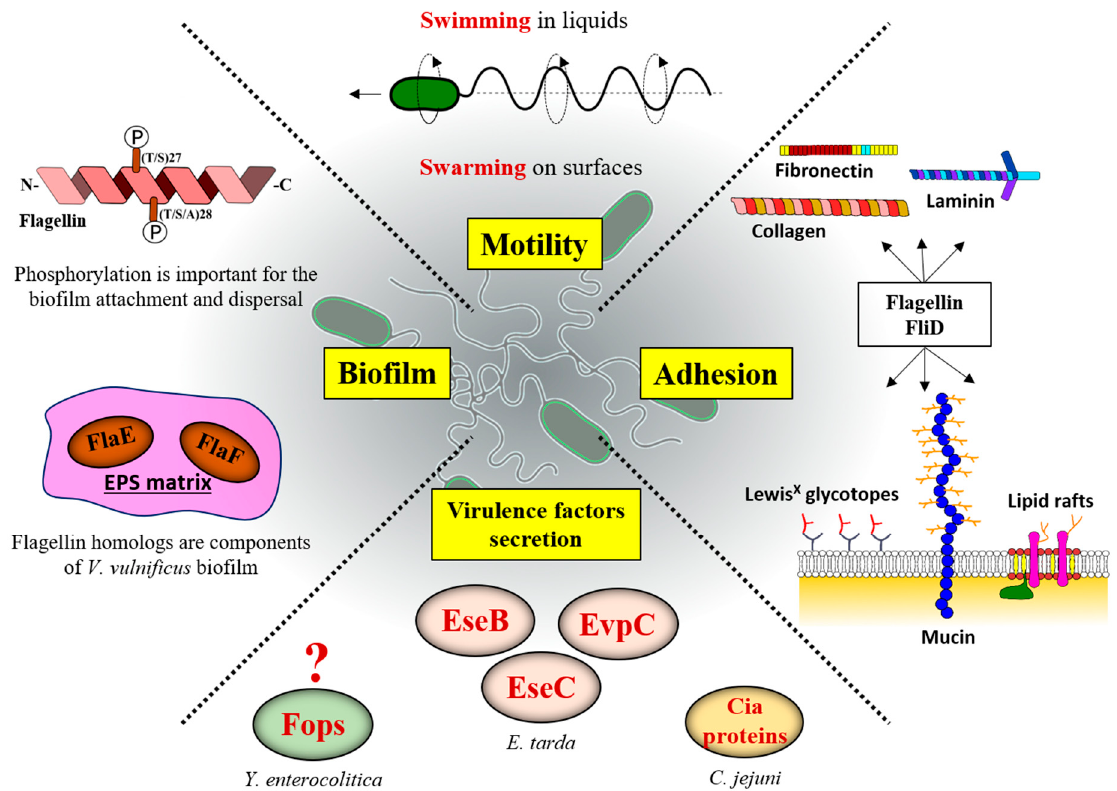
Figure 6. Flagellar filament, flagellin and FliD are implicated in various processes.